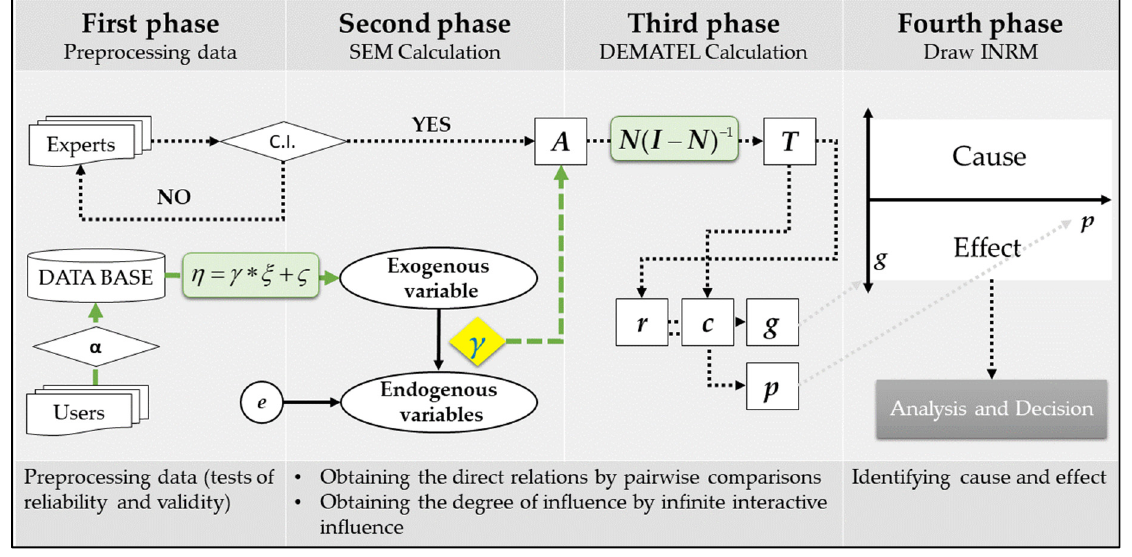
Figure 1. Analytical processes.